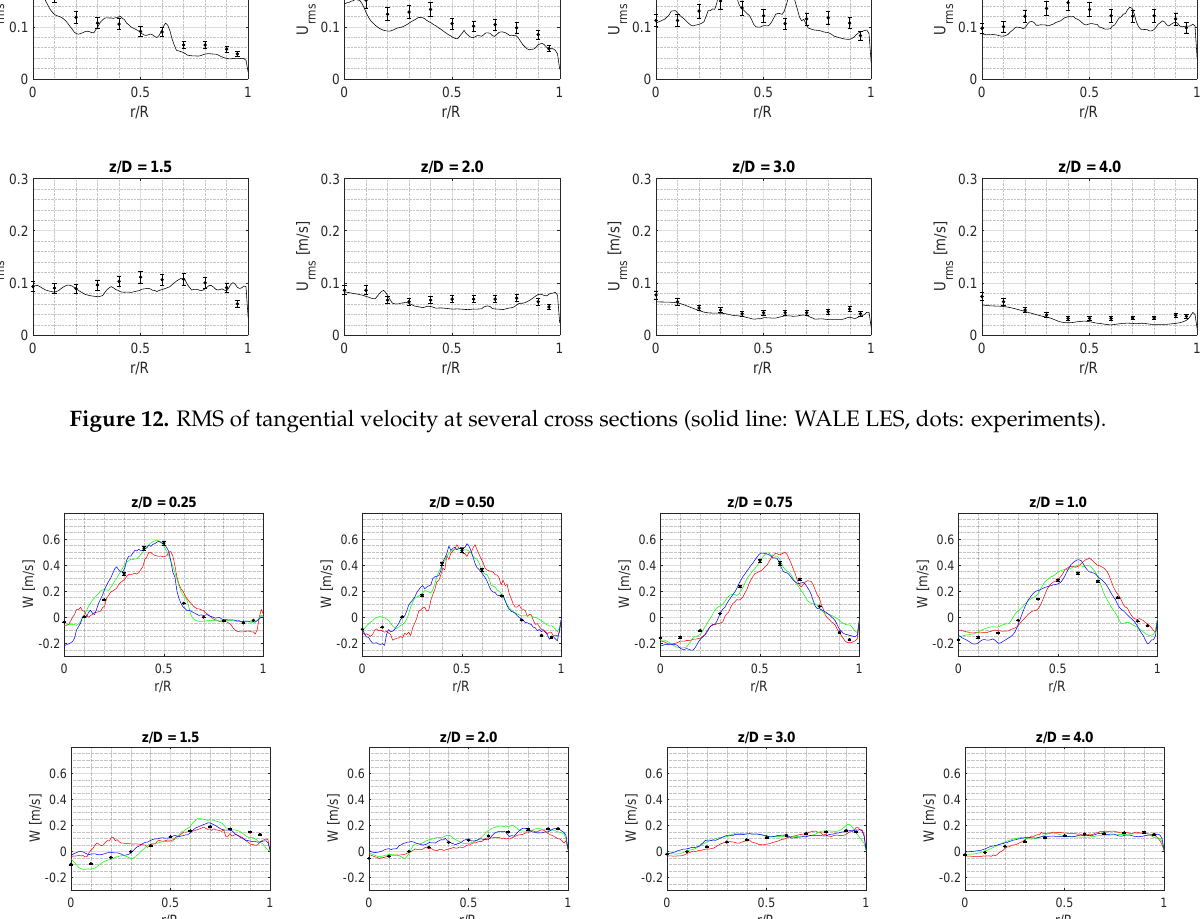
Figure 13. Mean axial velocity at several cross sections for different mesh resolutions (red: Mesh 1, green: Mesh 2, blue: Mesh 3, dots: experiments)